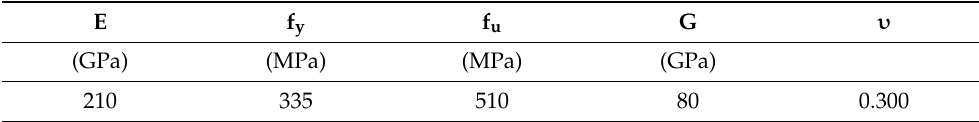
Table 5. Elastic and strength properties of A681